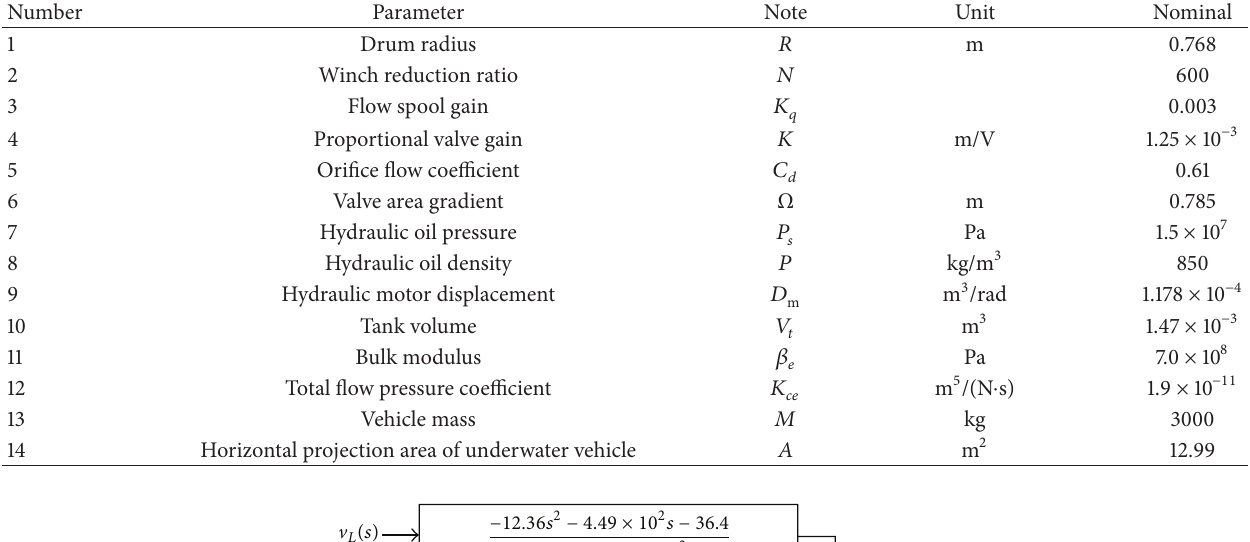
Table 1: The main nominal parameters of hydraulic system.